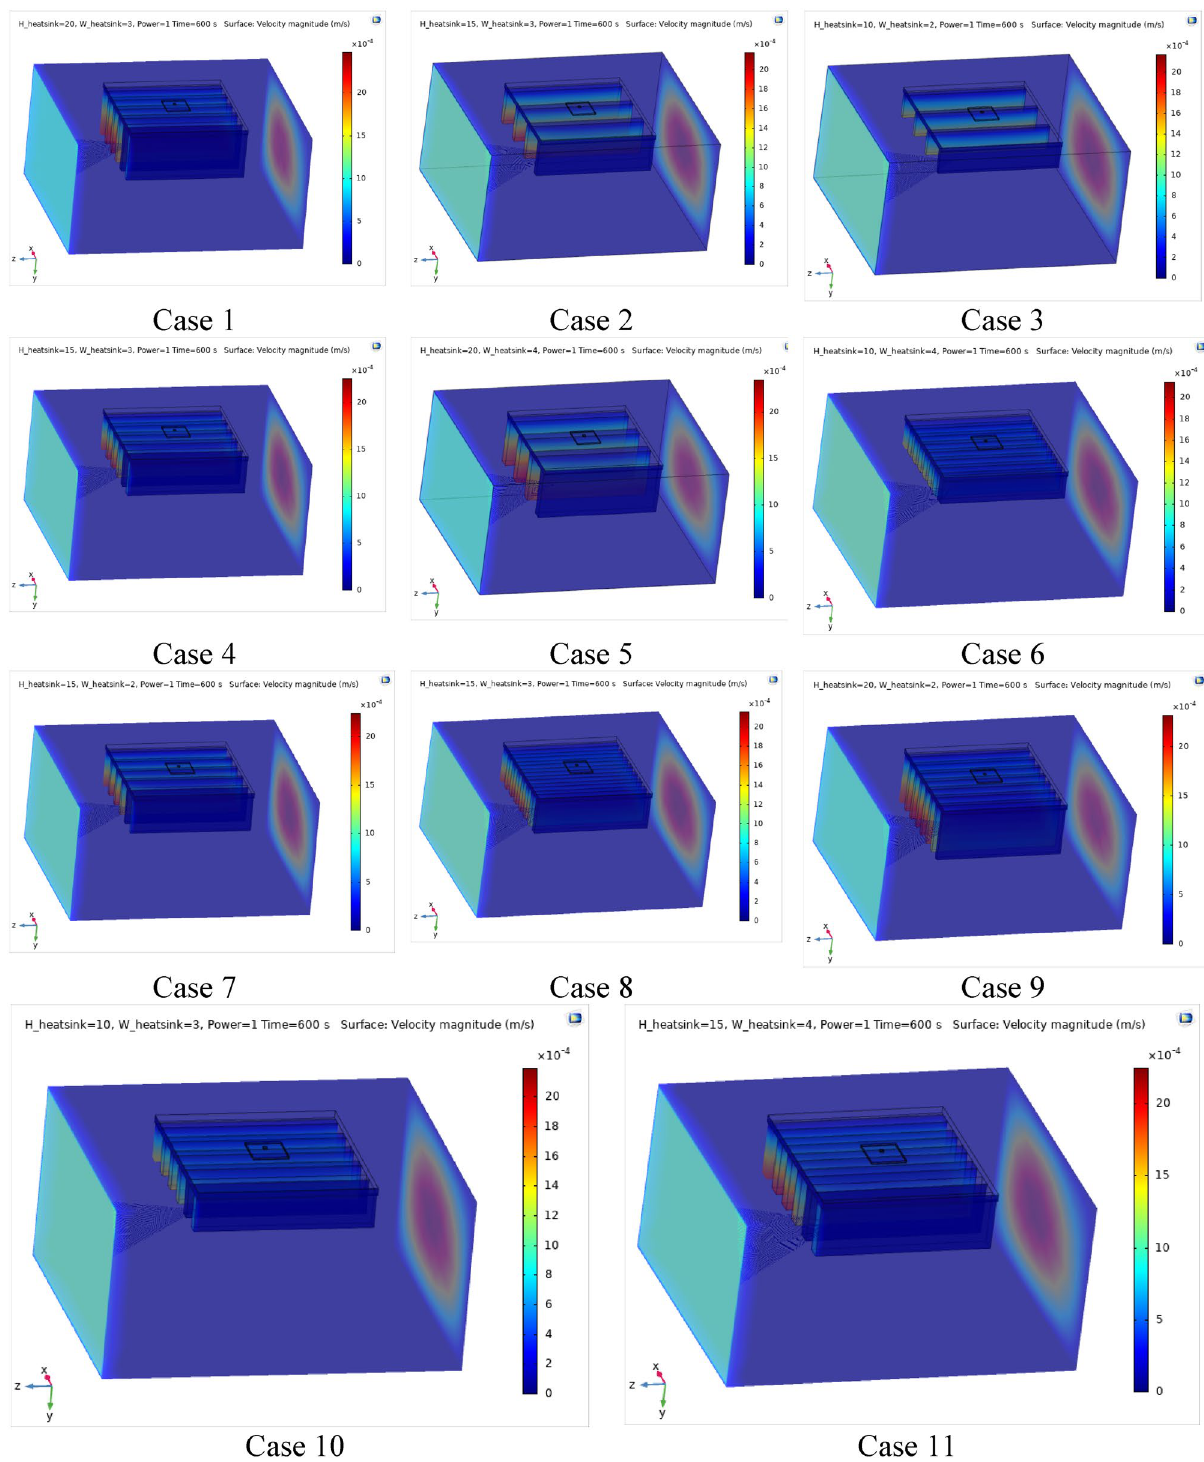
Figure 5. Velocity contours for the finned micro-channel of different geometries (11 Cases) (COMSOL Multiphysics 5.6, https:// www. comsol.